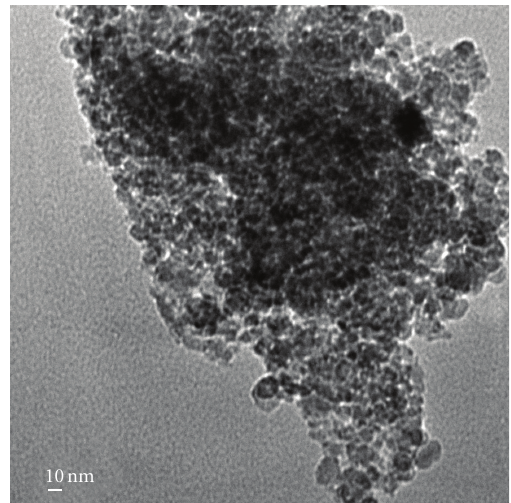
Figure 3: HRTEM photograph of SiC Powders.